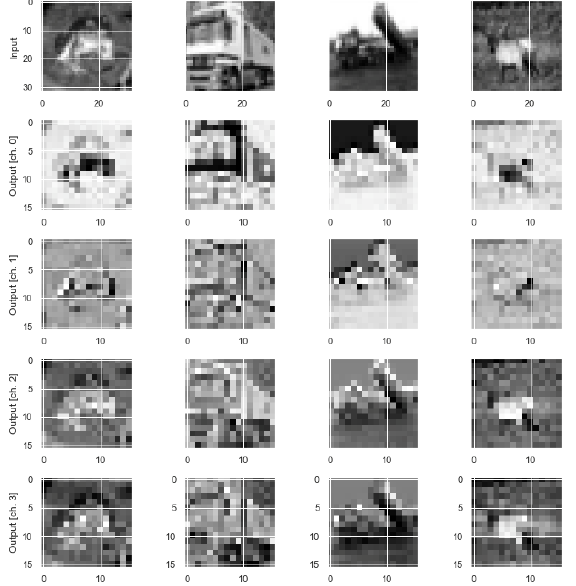
Figure 5. Example CIFAR-10 dataset images and corresponding output features using NNQE circuit.